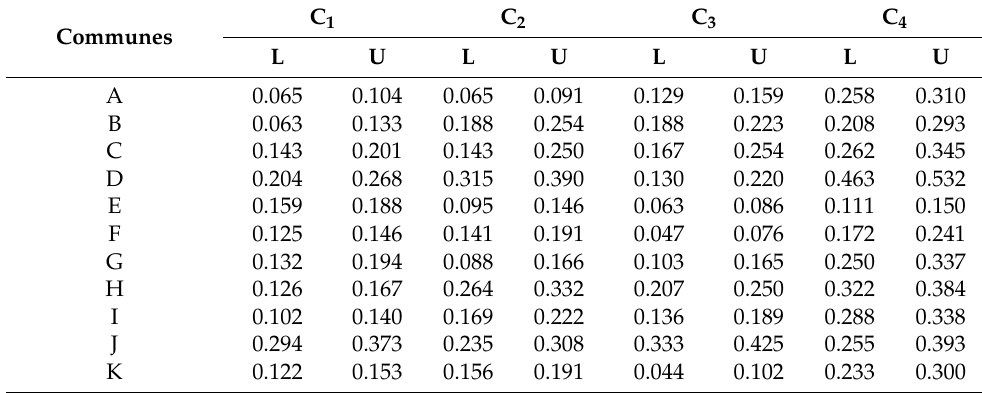
Table 7. Degrees of non-membership in the form of intervals for criteria C 1 –C 4 .